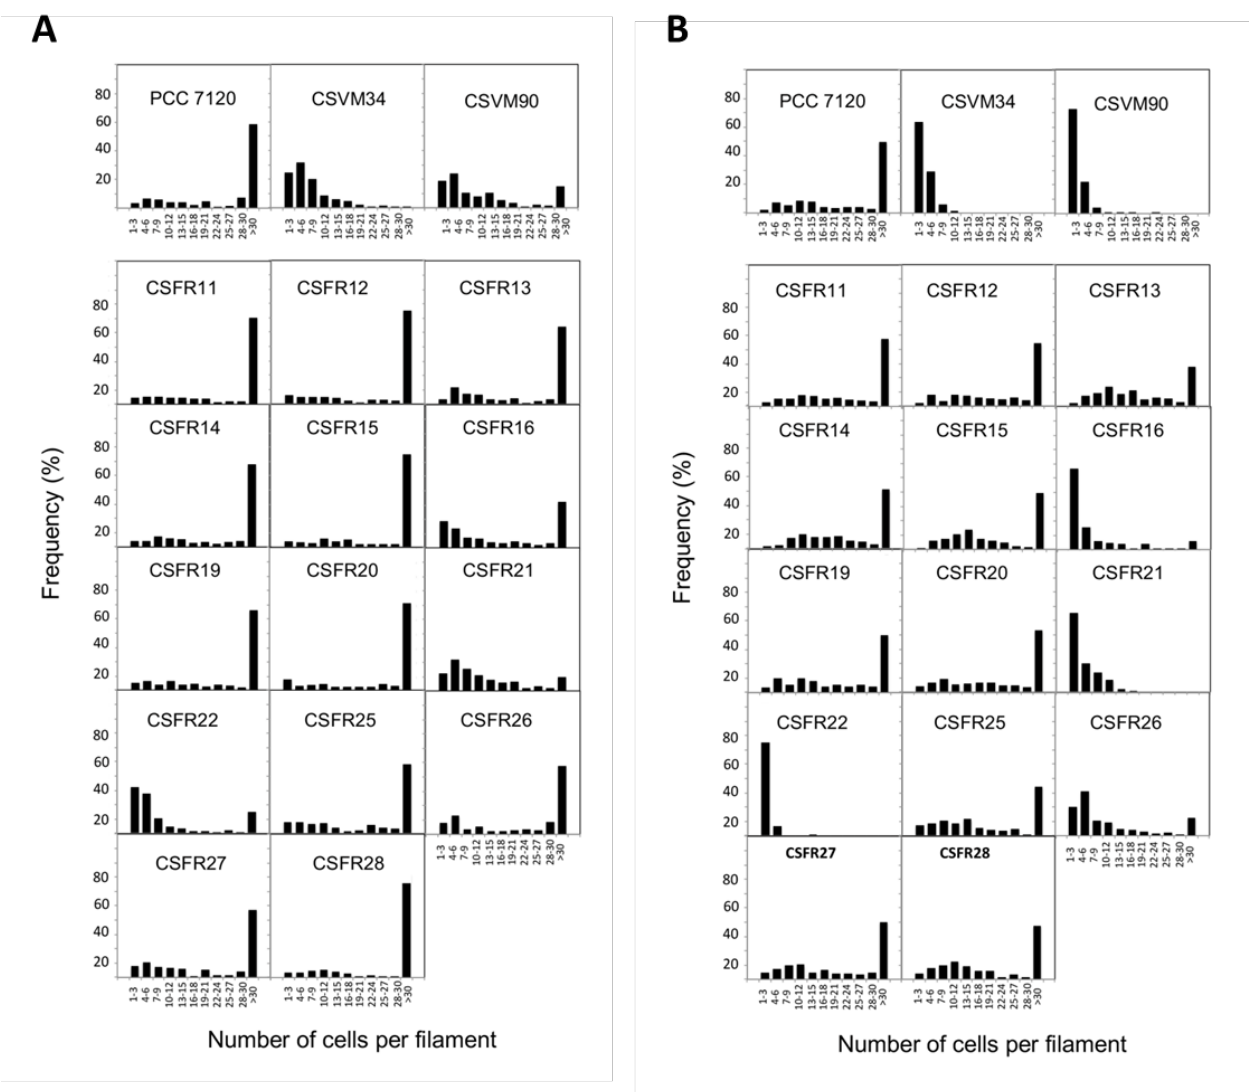
FIGURE 3: Filament length in Anabaena (PCC 7120) and sepJ mutant strains grown in BG11 medium (A) or grown in BG11 medium and incu- bated 48 h in BG11 0 medium